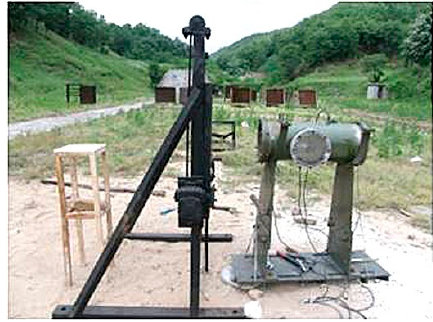
Figure 1. Field experimental device.